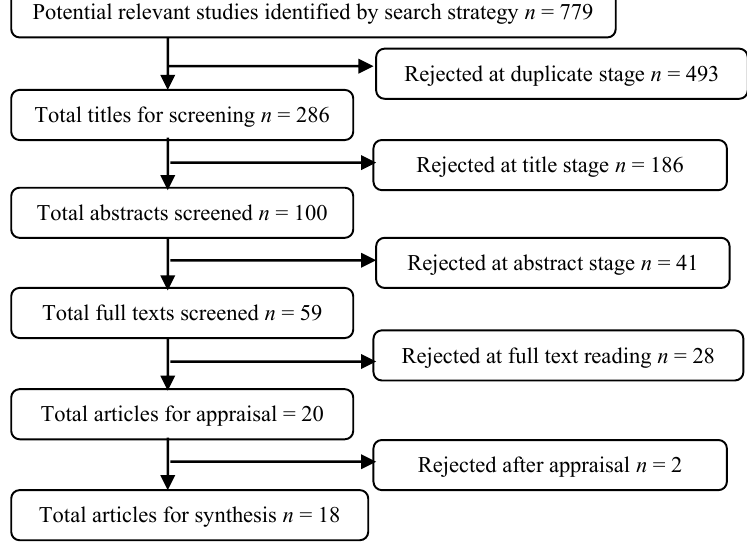
Figure 1. Flow diagram showing systematic review